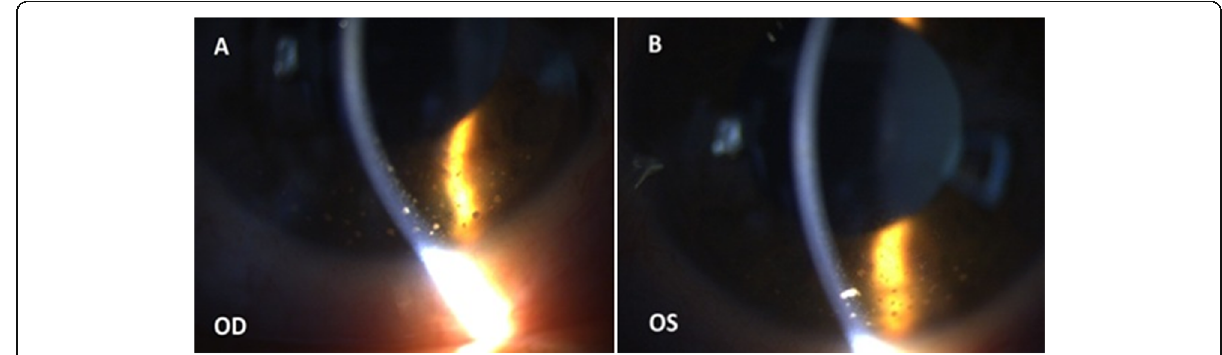
Fig. 1 Slit lamp photos of both eyes ( a and b ), slit beam illumination shows multiple variable size mutton-fat keratic precipitates inferior to the